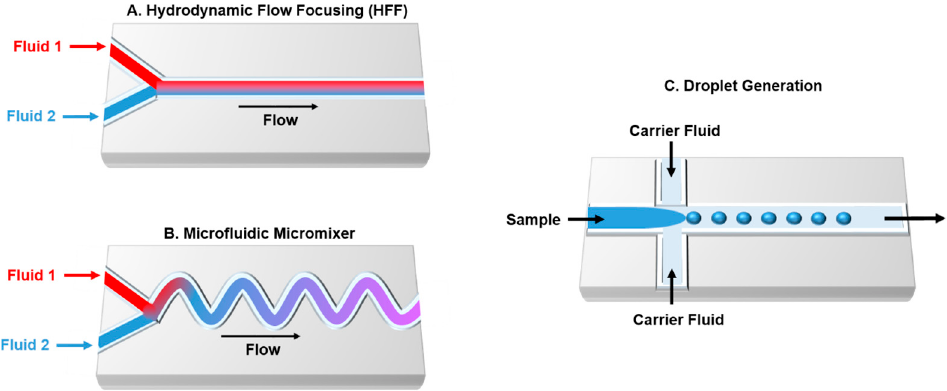
Figure 2. Examples of commonly used microfluidic techniques. ( A ) Microfluidic platform with hydrodynamic flow focusing; ( B ) microfluidic mixing chamber; ( C ) droplet-based microfluidic.